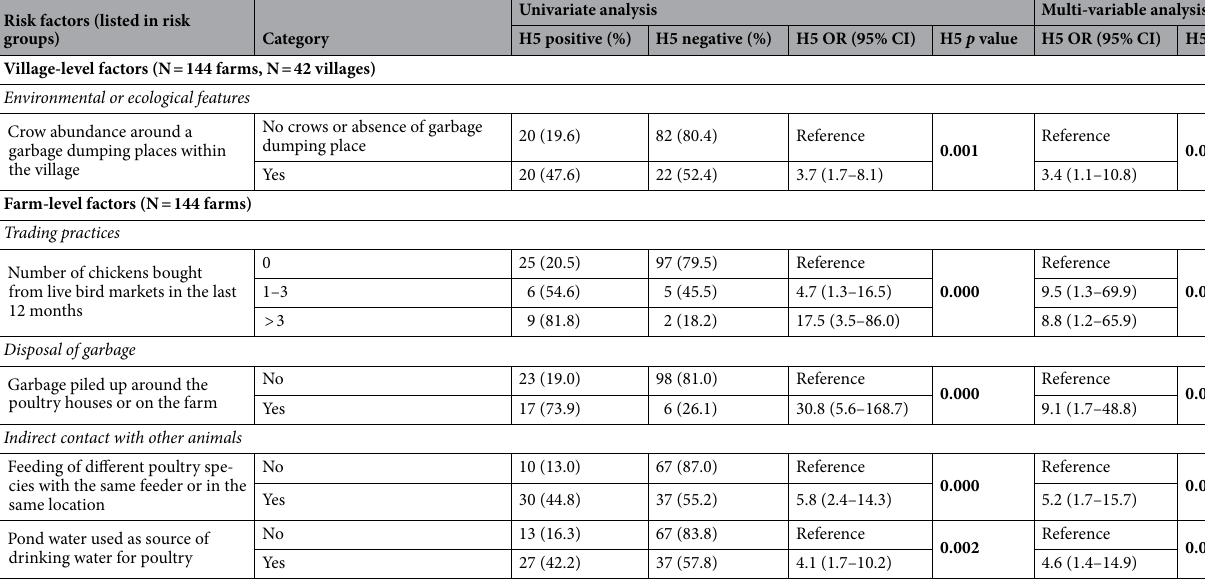
Table 1. Results of the univariate and multi-variable analysis for village and farm-level risk factors (N = 144 farms, N = 42 villages) associated with H5 flock-level seroprevalence on backyard chicken farms in Bangladesh, 2016. Significant values are in